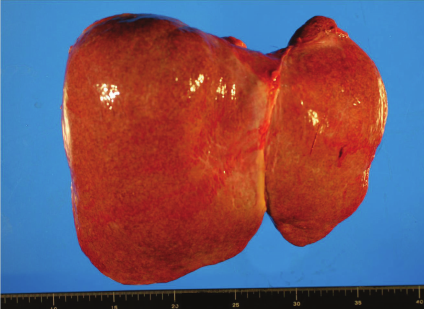
Figure 5: Microscopically, the lumbar vertebra shows hypercellular bone marrow with marked proliferation of plasma cells. Normal hematopoiesis appears suppressed (hematoxylin-eosin, original magnification ×